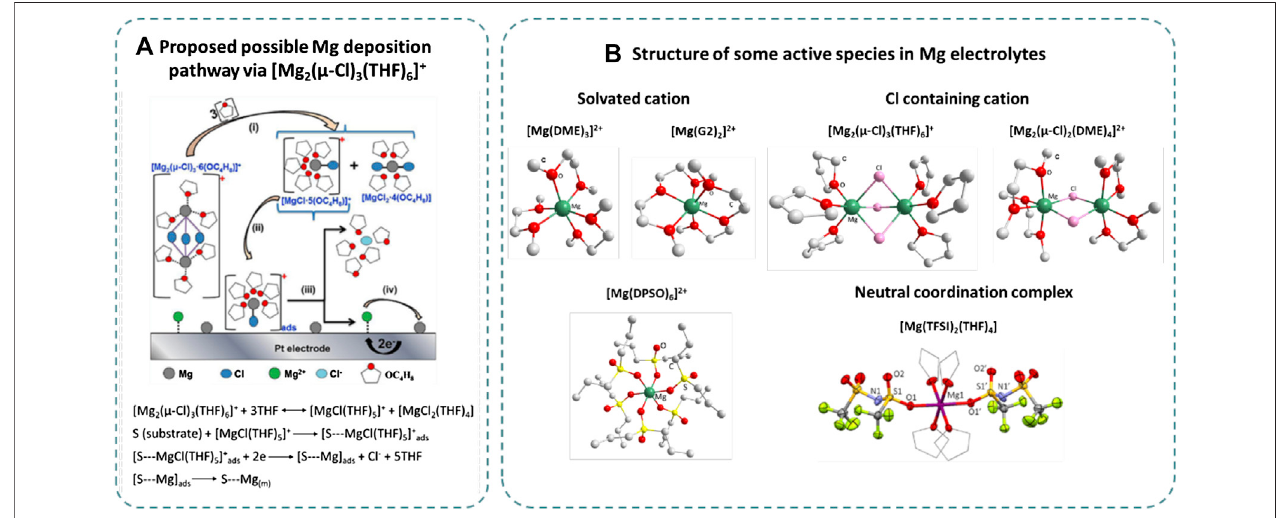
FIGURE 1 | (A) Proposed Mg deposition mechanism via [Mg 2 ( μ -Cl) 3 (THF) 6 ] + (Benmayza et al., 2013) and (B) structure of active species in non-nucleophilic Mg electrolyte (Cheng et al., 2015) (Liu et al., 2014) (Fan et al., 2020) (Kang et al., 2017) (Tutusaus et al., 2015), reproduced with